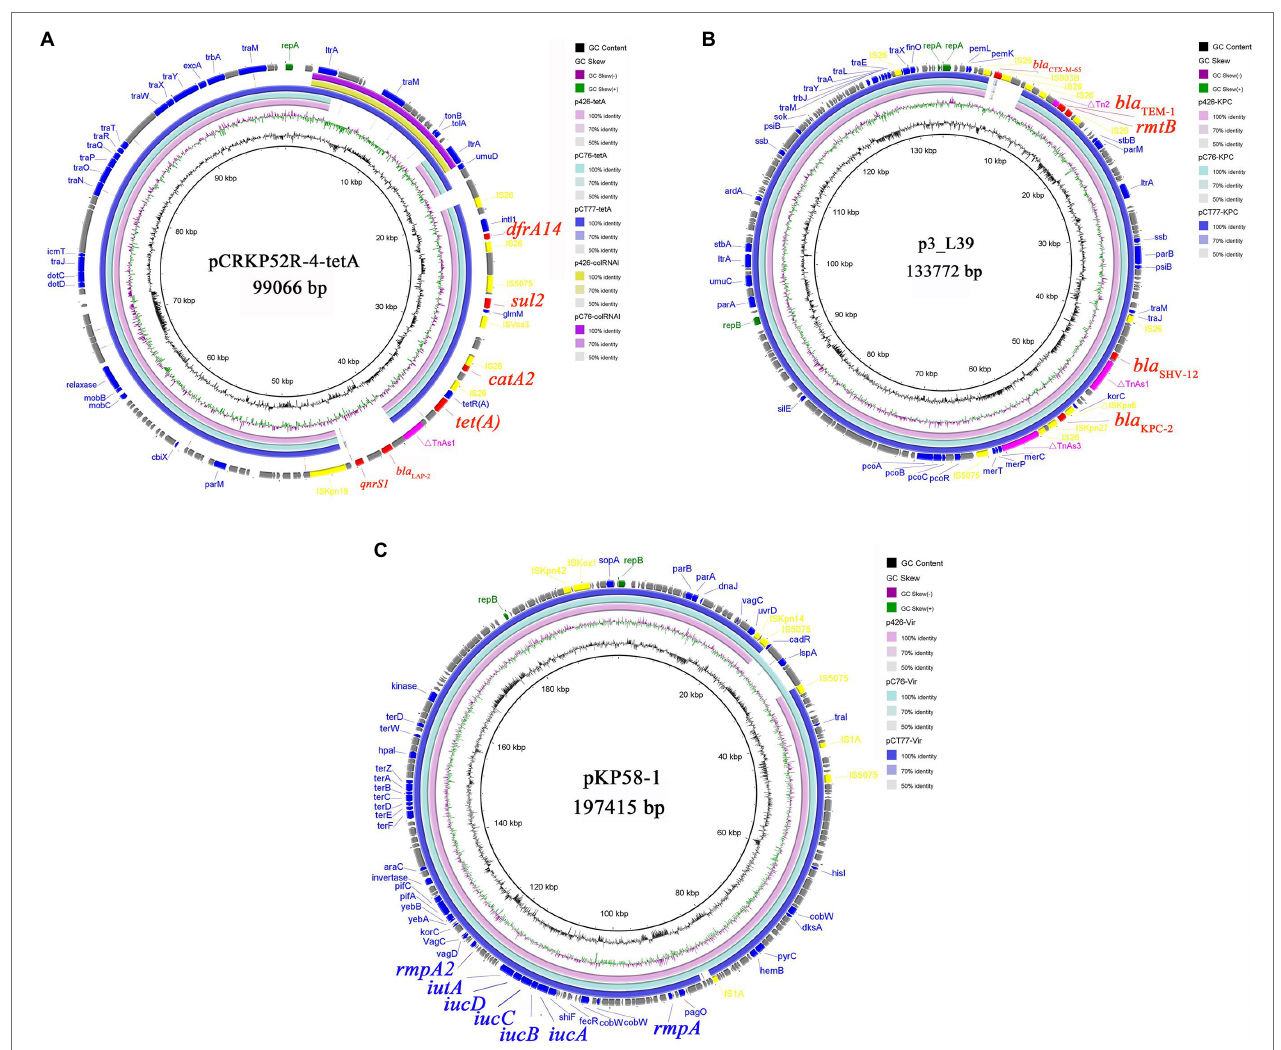
FIGURE 1 | Alignment of tet (A)-carrying plasmids (A) , bla KPC-2 -carrying plasmids (B) , and virulence plasmids (C) from Klebsiella pneumoniae KP-426, KP-C76, and KP-CT77. Circle 1 (the innermost) displayed the scale in kbp. Circle 2 and Circle 3 displayed the GC content and GC skew, respectively. The outermost circle displayed annotation of the reference